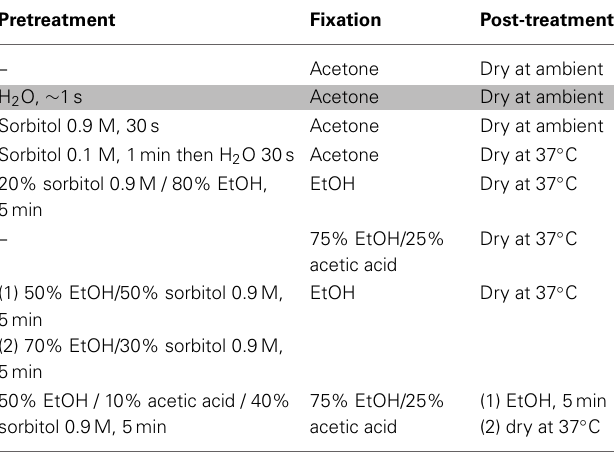
Table 1 | List of treatments tested to fix Ectocarpus filaments for